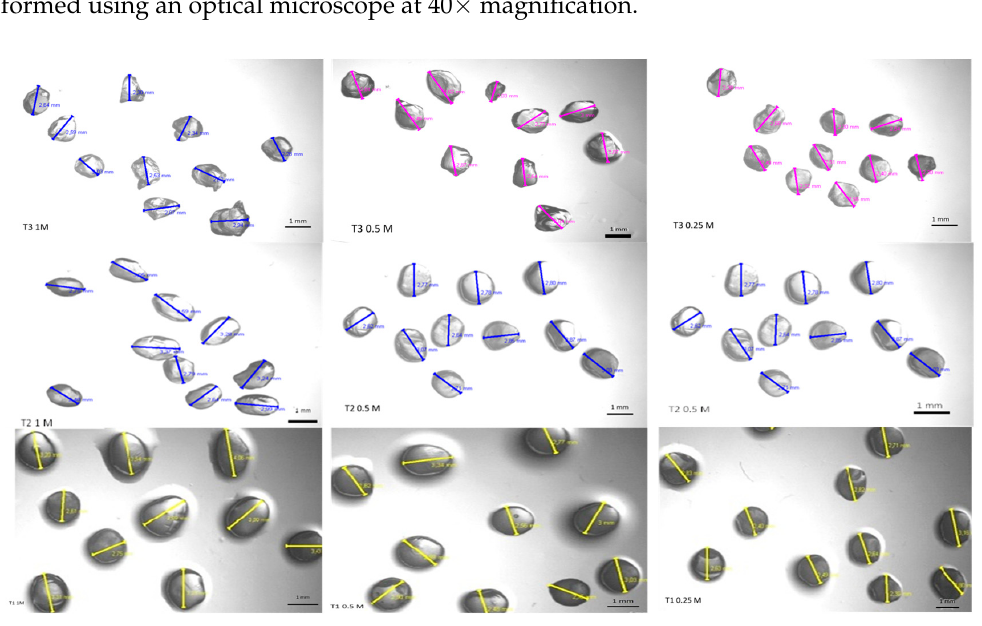
Figure 1. Size and morphology of the alginate particles produced with different sodium alginate and calcium chloride concentrations visualized through a microscope (magnification of 40×). T1, T2, and T3 contained 2%, 1.5%, and 1% of sodium alginate, respectively, and were crosslinked with calcium chloride at concentrations of 1, 0.5, and 0.25 mol·L − 1 . All alginate solutions contained phenolic compounds (2.55 mg gallic acid·g − 1 of microalgae).